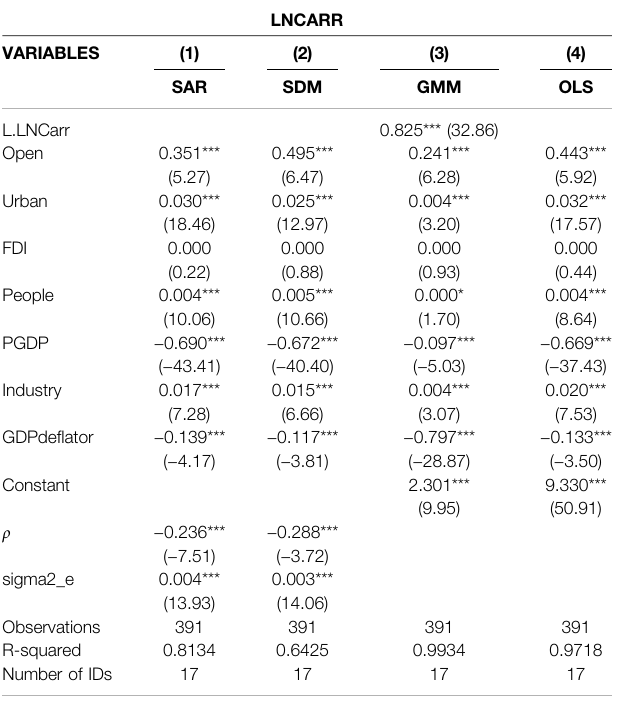
TABLE3| Empiricalanalysisresultsregardingtheeffectofforeigntradeoncarbon